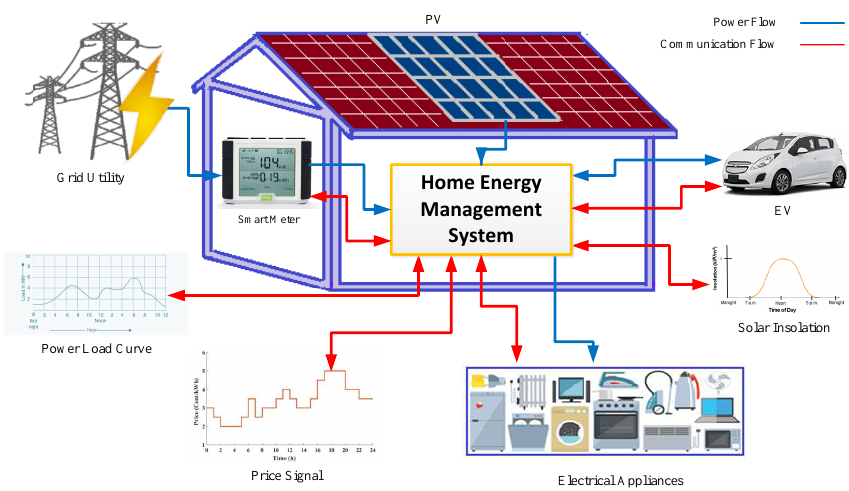
Figure 1. Structure of smart